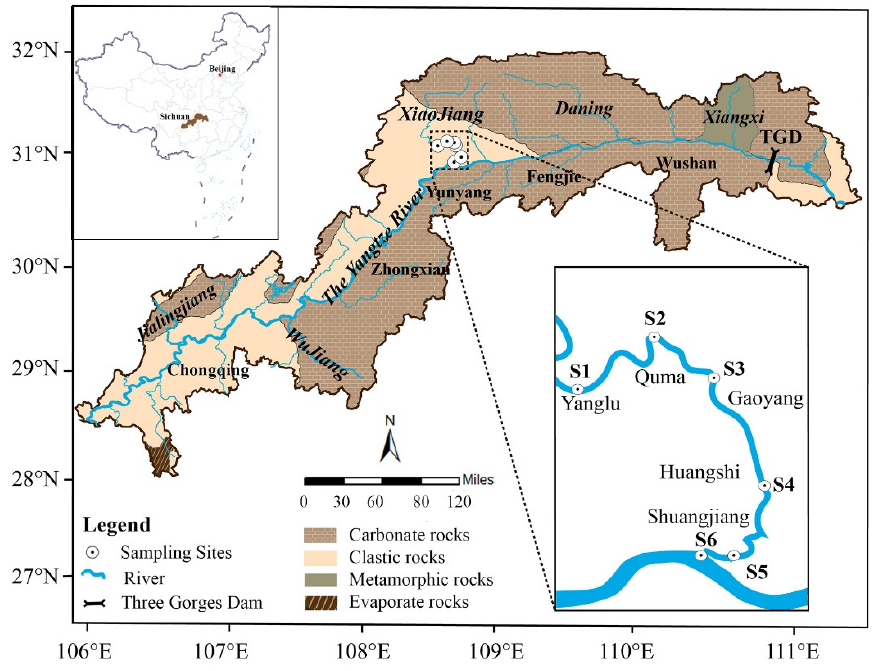
Figure 1. The lithologic distribution and sampling sites of Xiaojiang River in the TGR.